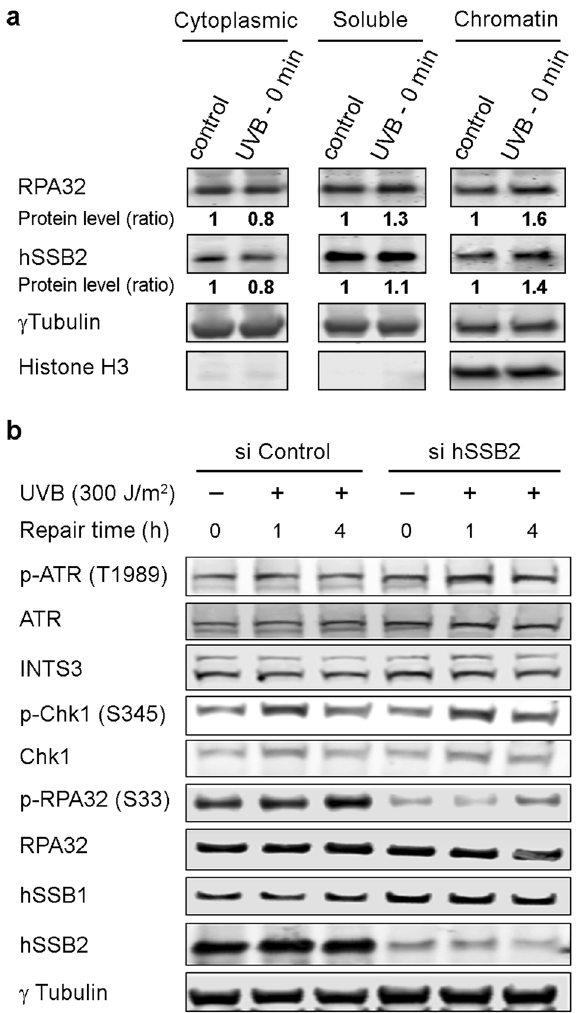
Figure 2. hSSB2 depletion does not affect signalling after UVB irradiation but reduces phosphorylation of RPA. ( a ) Cytoplasmic, soluble and chromatin fractions of protein extracts from HeLa cells control un-irradiated and straight after 300 J/m 2 UVB exposure (0 min) were probed for the proteins hSSB2, RPA32, γTubulin and histone H3. Ratios of RPA and hSSB2 protein levels to control sample are indicated below the corresponding blot. γTubulin was used to normalise hSSB2 and RPA levels for cytoplasmic and soluble fractions. Histone H3 was used to normalise hSSB2 and RPA levels for chromatin fractions. Blots are representative of 3 independent experiments. ( b ) Representative western blot over 3 experiments for HeLa cells irradiated with 300 J/m 2 UVB 48 h after transfection with control and hSSB2 siRNAs. Cells have been collected 1 and 4 h after irradiation. Blots have been probed with indicated antibody, γ-Tubulin is used as a loading